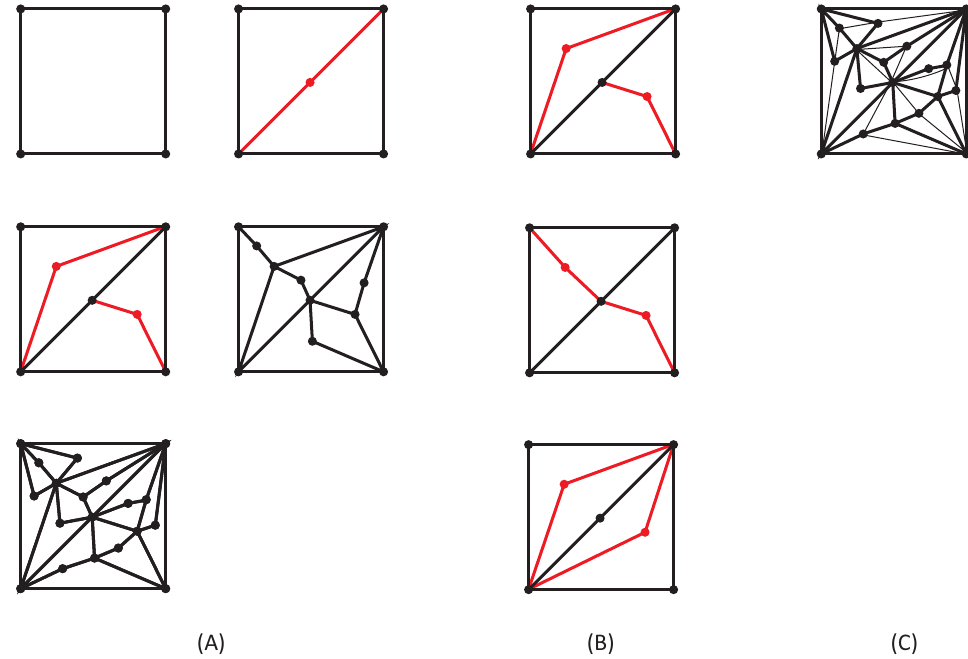
Figure 2. Constructionof a tetragon-based network: ( A ) representatives of the tetragon-networks up to the 4th generation; ( B ) three possible topologically different realizations of the second-generation network; ( C ) random triangulation of the fourth-generation